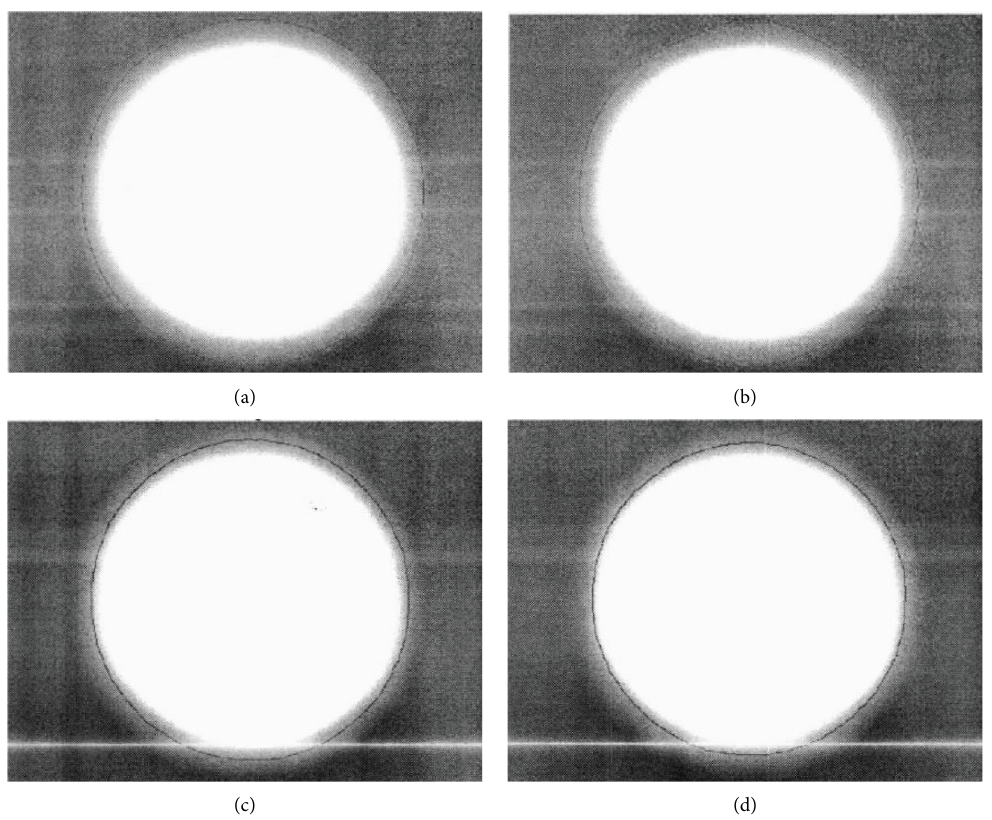
Figure 4: Known snake algorithm detection. (a) Initial contour image. (b) Traditional snake algorithm. (c) Balloon force snake algorithm. (d) Research on improved snake algorithm.